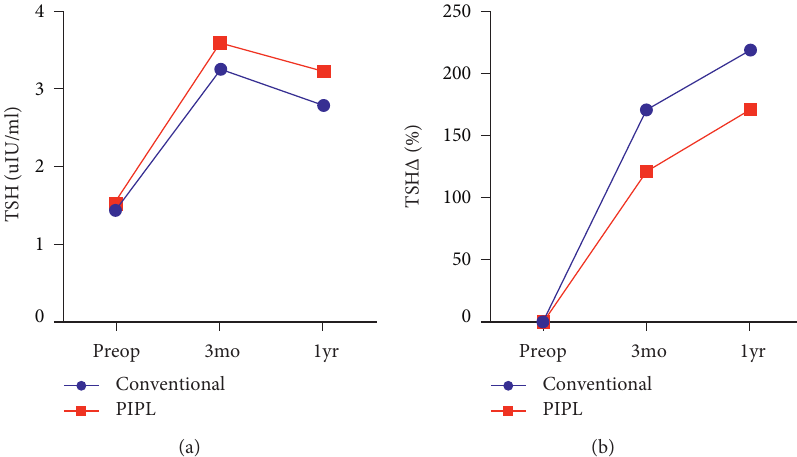
Figure 4: Mean thyroid-stimulating hormone (TSH) concentrations and changes during the study in the conventional and PIPL groups. (a) Serum TSH concentration before surgery, and 3 months and 1 year following thyroid surgery. (b) Changes in the serum TSH concentration during the first year following thyroid surgery. Table 3: Incidences of hypothyroidism and euthyroidism after thyroid surgery in the conventional and PIPL groups. Conventional